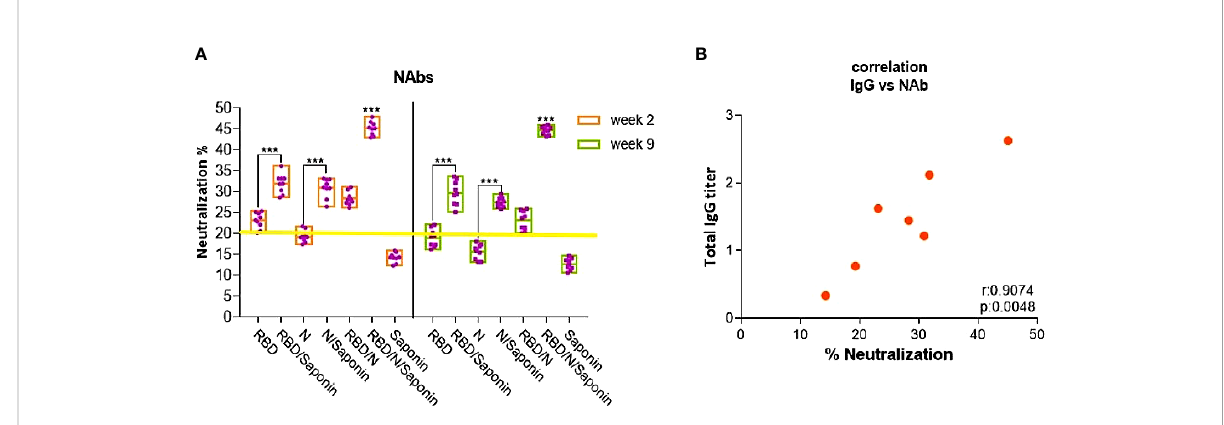
FIGURE 5 Mean percentages of SARS-CoV-2 neutralizing inhibition. The yellow line represents the sVNT cut-off. PI results < 20% are reported as “ negative ” , and PI = 20% are reported as “ positive ” (A) . Comparison of speci fi c IgG endpoint titers with SARS-CoV-2-speci fi c neutralizing inhibition (B) . Correlation analysis was performed by log transformation of the endpoint ELISA or NAbs titers followed by linear regression analysis *** for P<